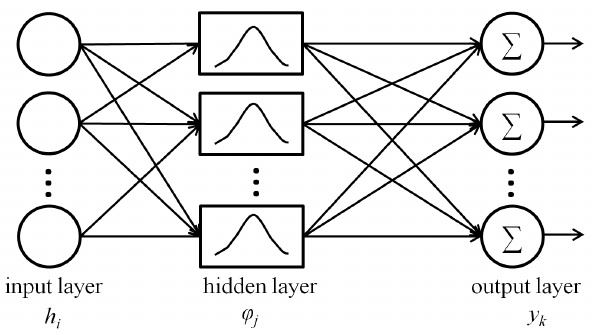
Figure 7. Architecture of a RBF network.